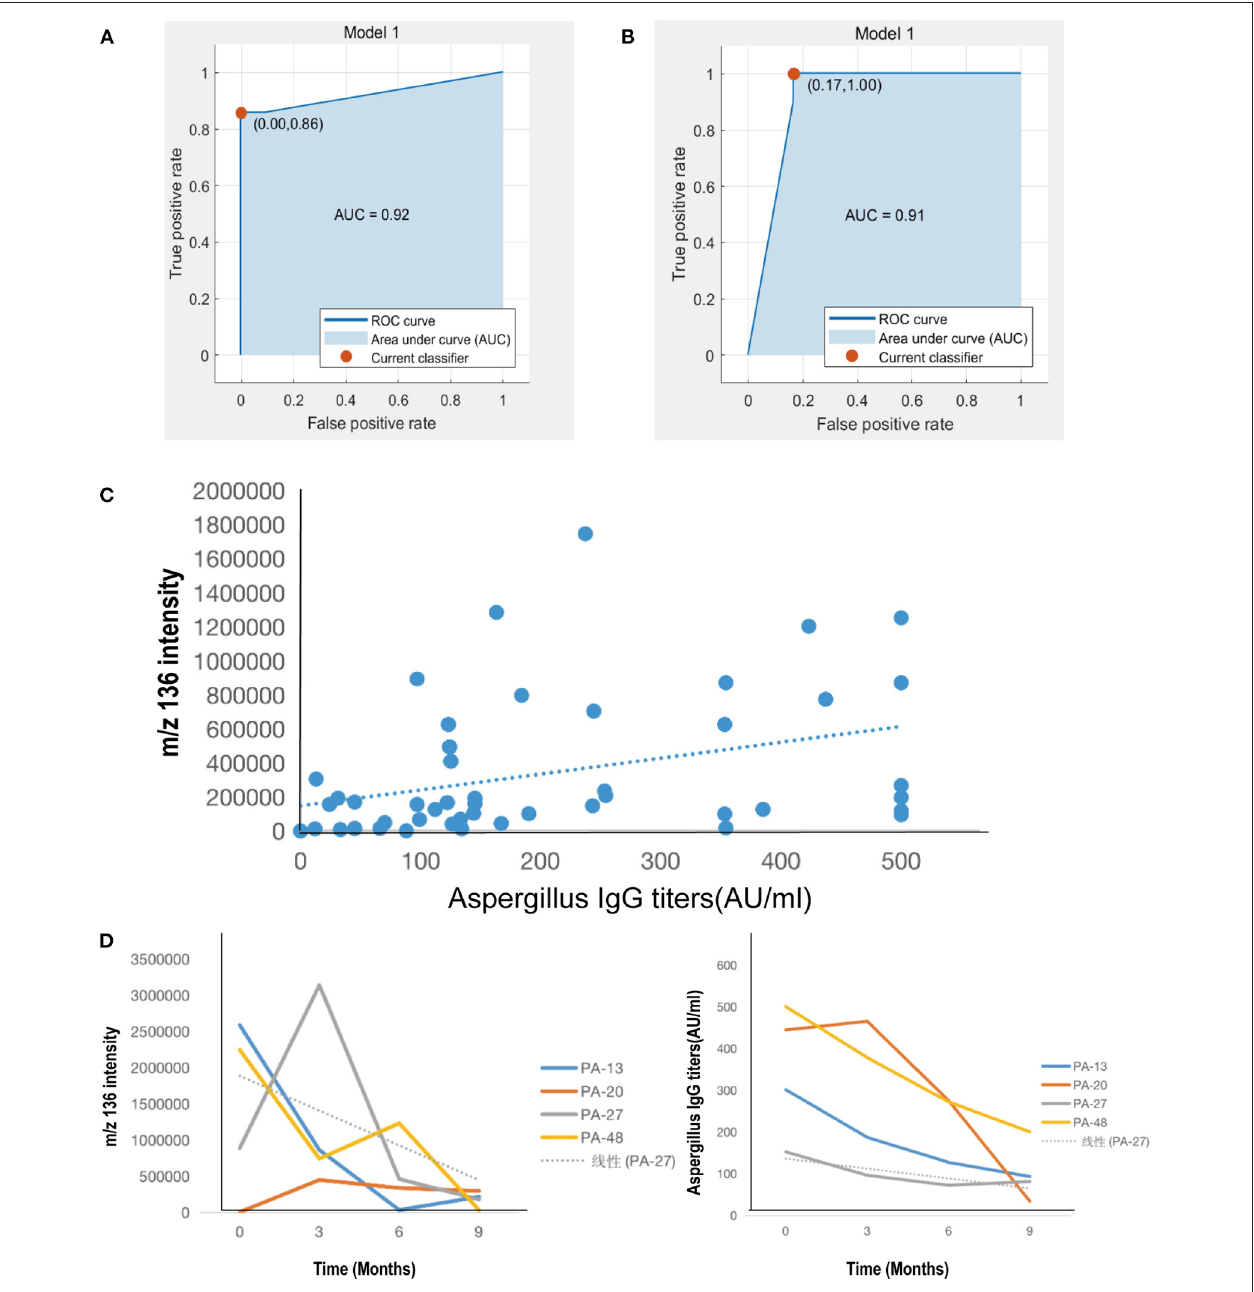
FIGURE 4 | Clinical correlation of characteristic VOCs in exhaled breath of patients with CPA. (A) Univariate logistic regression model of the CPA group and CAP group. (B) Univariate logistic regression model of group CPA and group N. (C) Correlation analysis between characteristic VOCs and serum anti- Aspergillus fumigatus IgG antibody titers. (D) Dynamic changes in levels of breath characteristic VOCs and serum anti- Aspergillus fumigatus IgG antibody titers of 4 patients in the CPA group for baseline and follow-up in the third, sixth, and ninth month after voriconazole treatment.